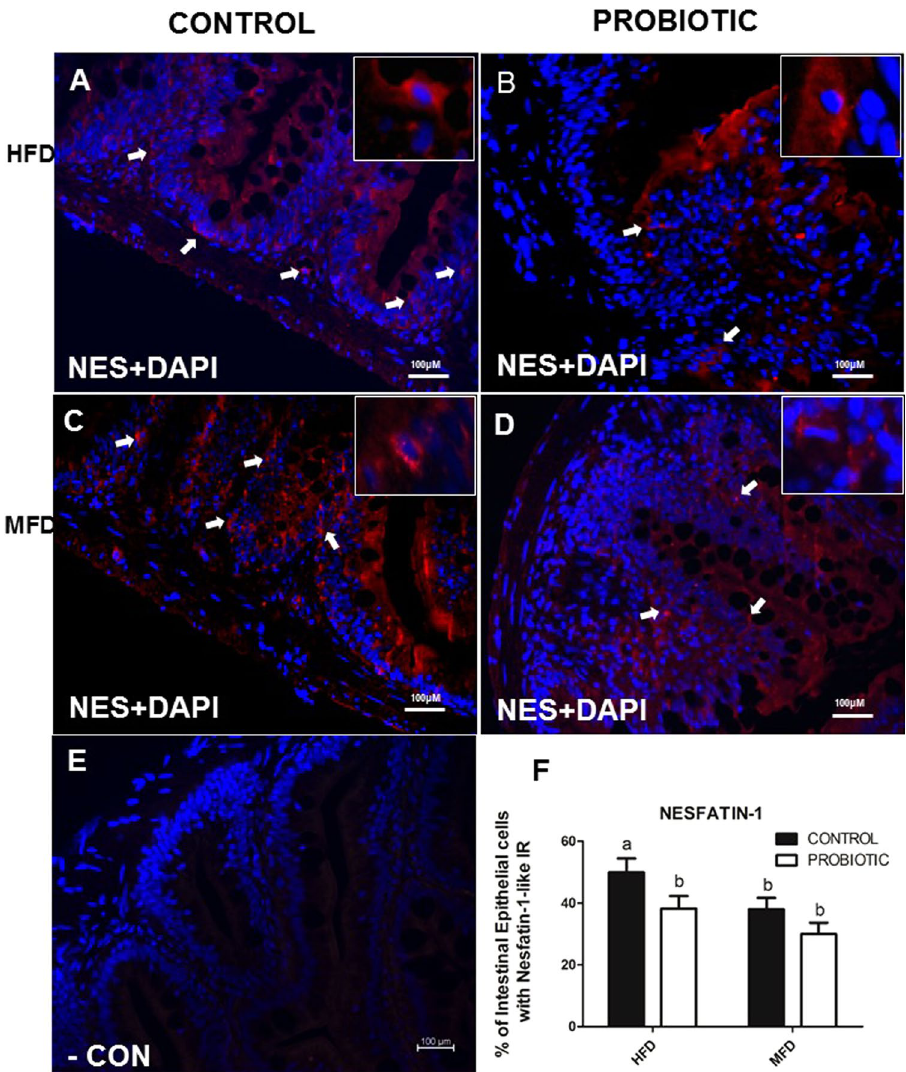
Figure 3. NUCB2/nesfatin-1-like ir in the gut of zebrafish fed with HDF-P and HFD-C compare to MFD-C. Cross sections of the zebrafish for nesfatin-1-like show higher abundance of nesfatin-1-like cell in HFD-C compared to HFD-P (3 F). For details on methods employed for percentage of positive intestinal epithelial cells calculation, please consult the Materials and Methods section. Values with different superscript letters are significantly different ( p <